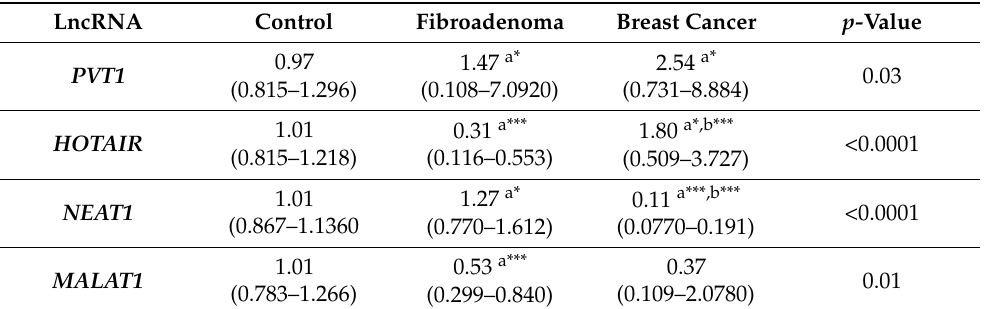
Table 3. Relative expression levels of serum PVT1, HOTAIR, NEAT1, and MALAT1 in the control, fibroadenoma, and the breast cancer